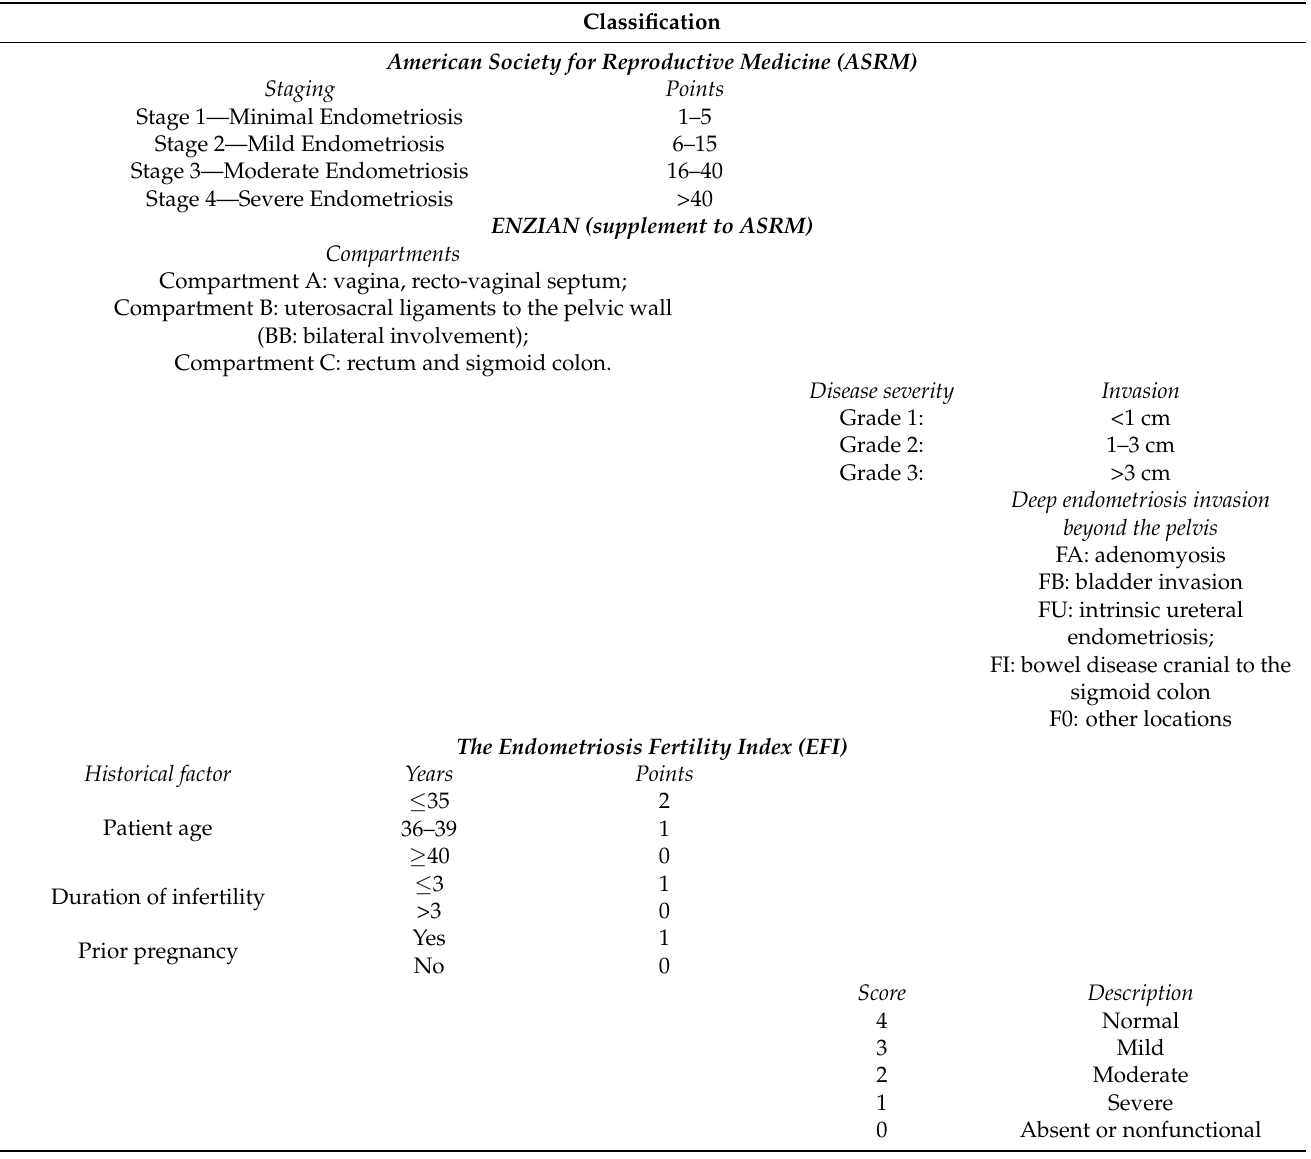
Table 1. Classification of